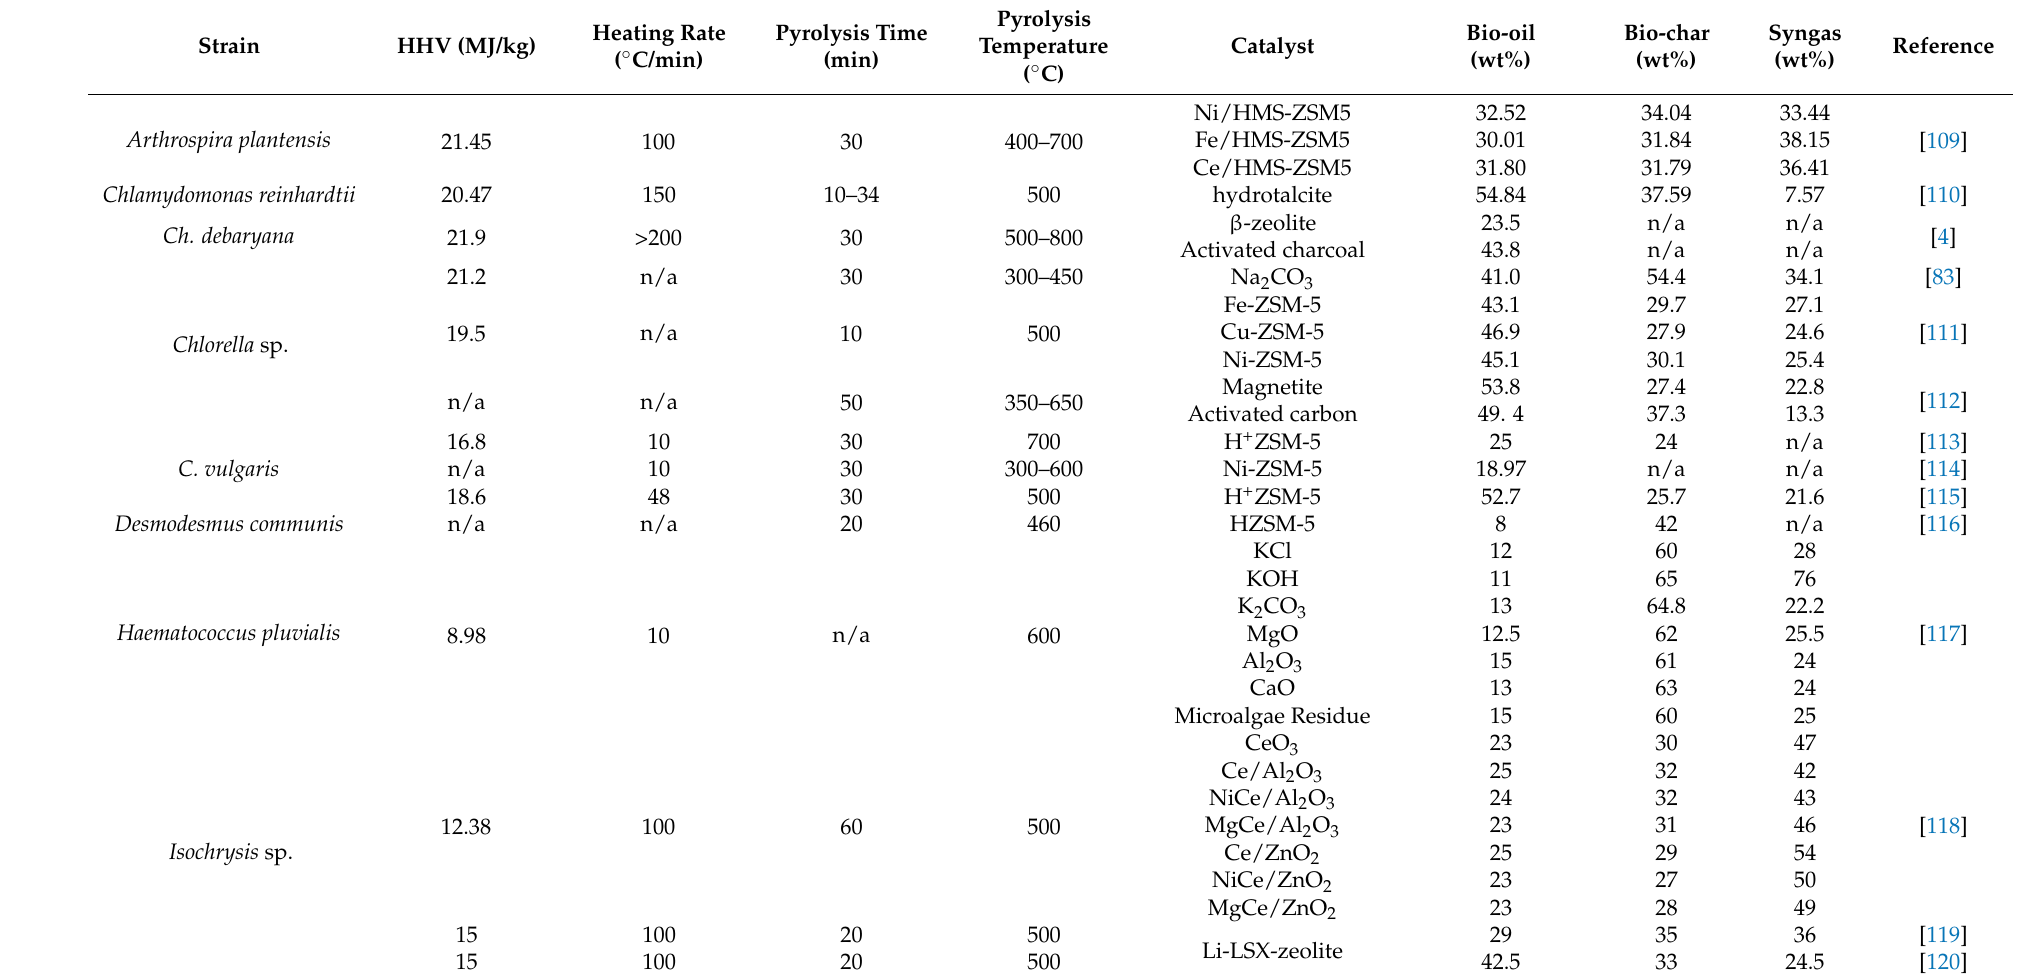
Table 2. Strains studied on catalytic pyrolysis and their